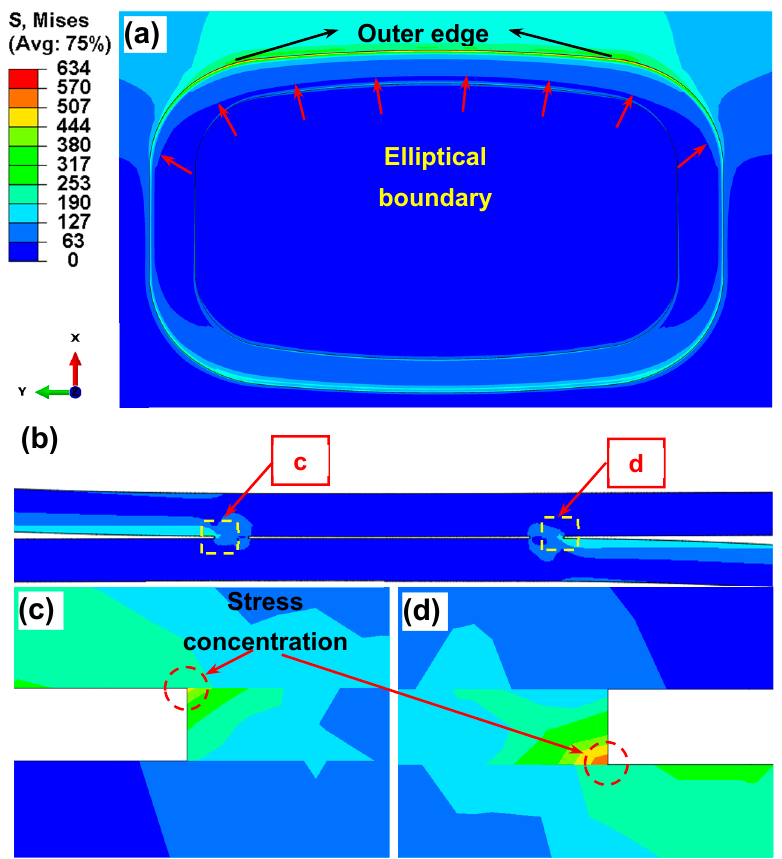
Figure 7. Distribution of von Mises stress and stress concentration area by FEA simulation. ( a ) von Mises stress on the fracture surface; ( b ) deformation and stress concentration zone on the cross section, and a magnified view of the cross-sectional stress concentration zones on the ( c ) Cu side and ( d ) Al side.